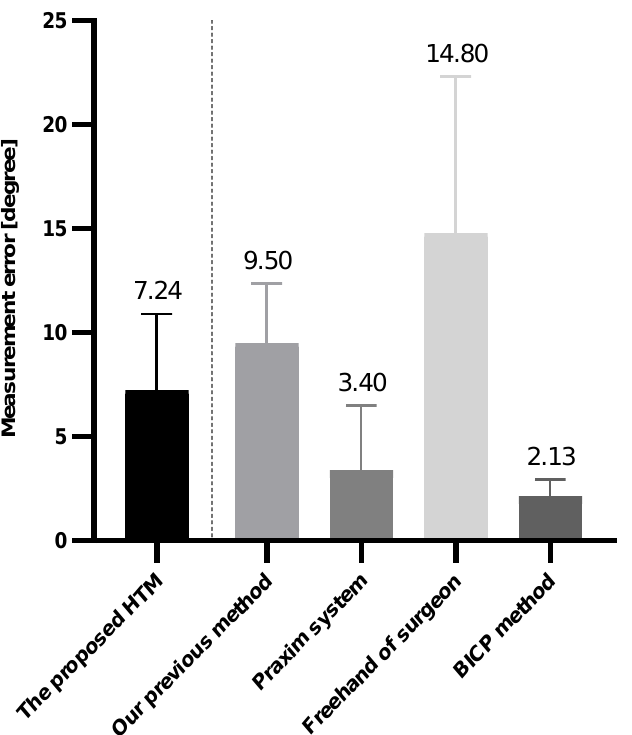
Figure 10. Comparison with localisation techniques and surgical navigation systems that were developed for OAT in the last ten